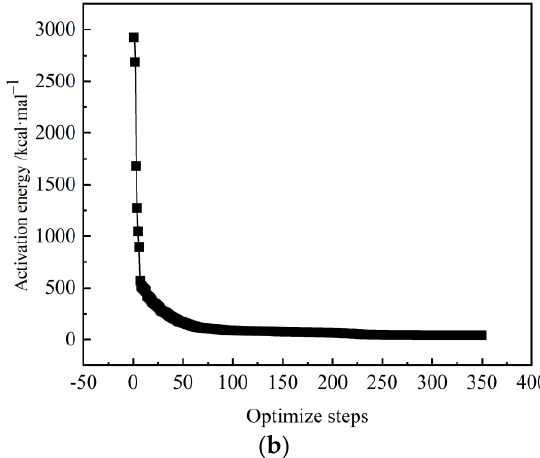
Figure 6. XLPE molecular model and optimization process. ( a ) Molecular structure model of XLPE; ( b ) energy changes in the molecular structure of XLPE.